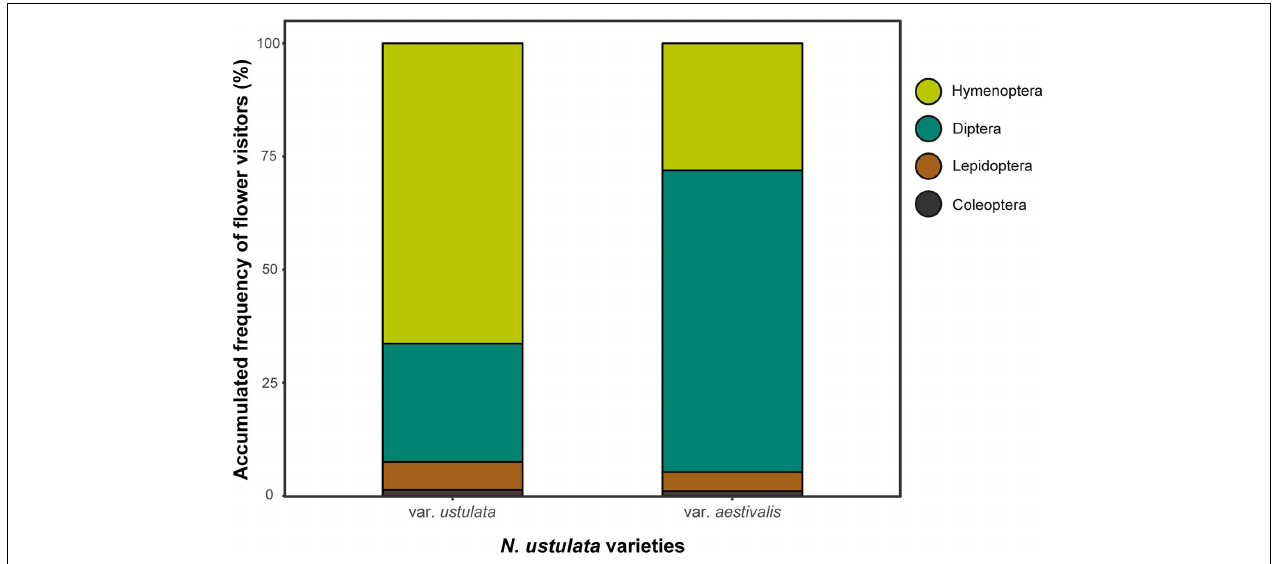
FIGURE 7 | Percentage of floral visits by insect groups to Neotinea ustulata var. ustulata and var. aestivalis . Insects were classified at the taxonomic order rank. Note that the graphs are based solely on video recordings. For records of insect diversity and insect responses see Supplementary Table 5 .